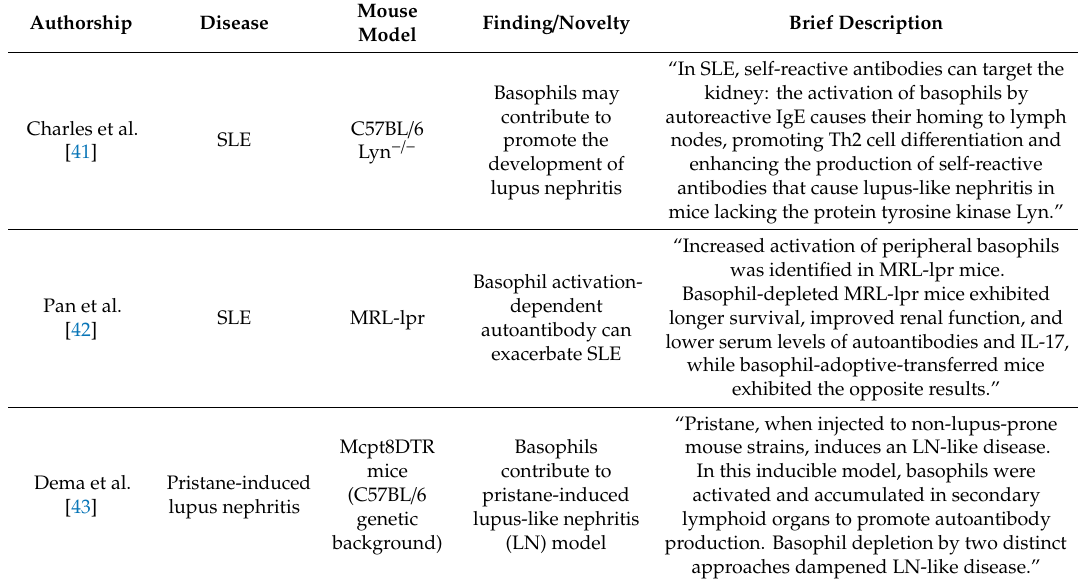
Table 1. Search output of lupus murine models providing information on basophils.